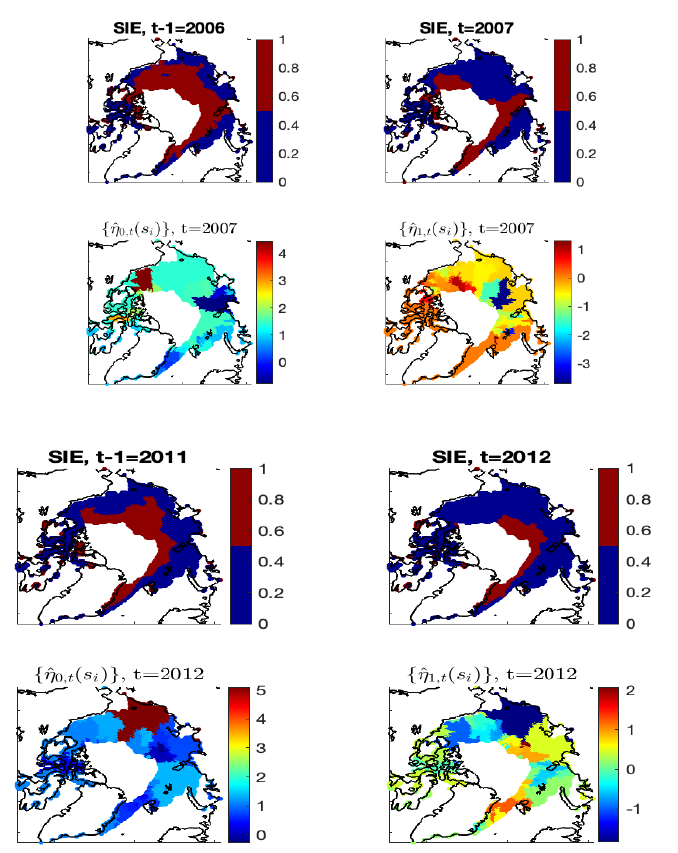
Figure A7. Spatial maps of the observed ice/water statuses at t − 1 and t and the autoregressive-